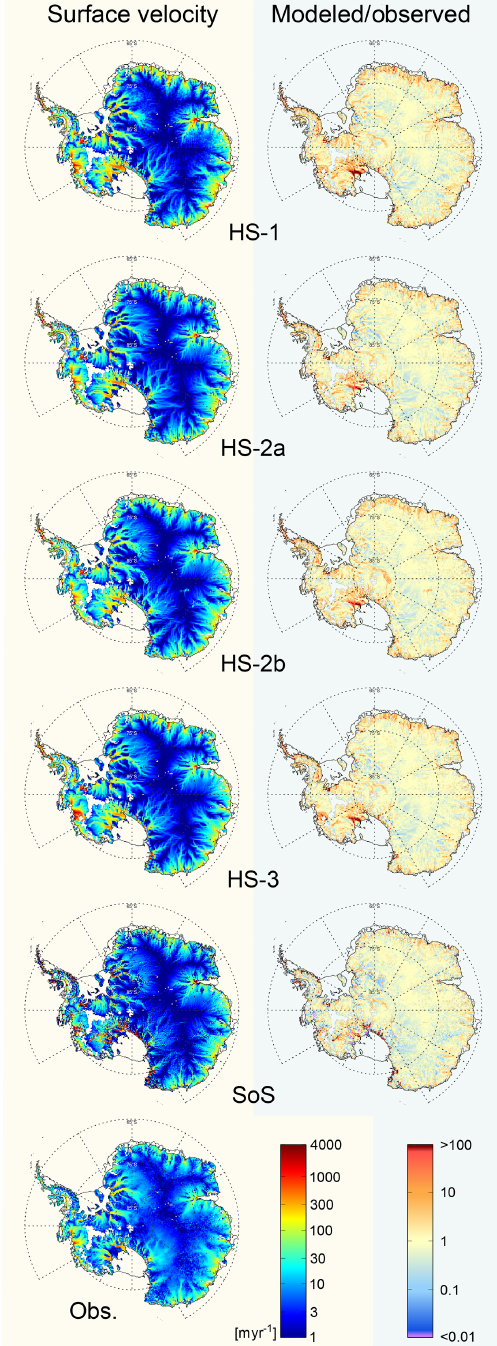
Figure 3. Comparison of the ice-sheet states derived from different schemes at the end of equilibrium simulations. Left column: differ- ences between the modelled and observed ice thickness, in metres. Right column: inferred distributions of basal sliding coefficients, in myr − 1 Pa − 1 . Non-coloured areas mark the locations where basal sliding is not identified and the calibration procedure does not oper- ate. Colour-code saturates at the upper and lower limits allowed for the calibration procedure.